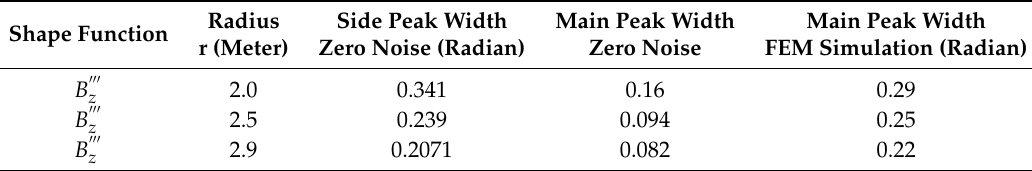
Figure 9. ( a ) Results with zero noise: Keeping the depth h constant at 0.3 m, 3rd order derivative at r c = 2.9 m provides best results having maximum peak amplitude and minimum peak width. ( b ) Results with noise from derivation: 3rd order derivative at r c = 2.9 m, 2.5 m and 2 m, plot has added noise due to inherent property of derivation and FEM-based software. Table 2. Comparison of effect on peak width due to varying radius of